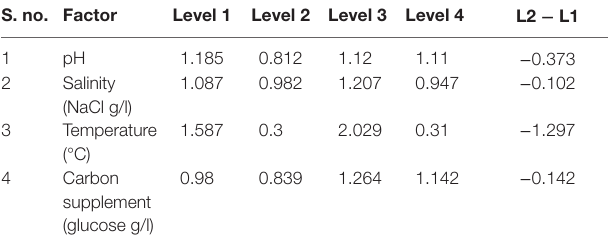
TaBle 5 | Main effects of selected factors on carbohydrates